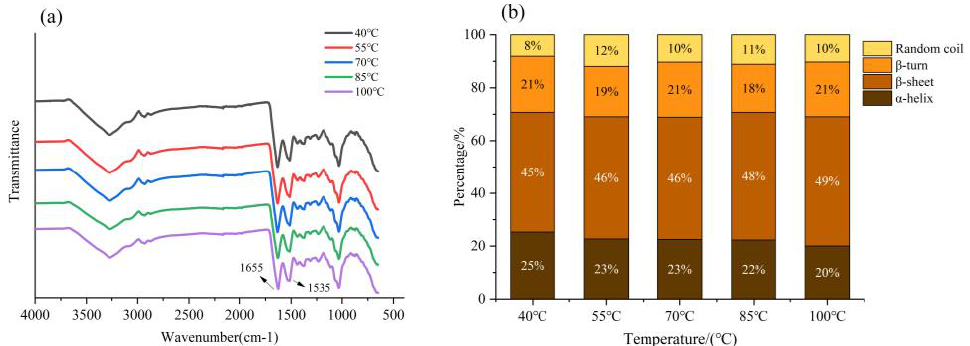
Figure 6. ( a ) FTIR spectrum of EBN insoluble fraction; ( b ) the secondary structure contents. The spectra in the wavenumber range of 1700 – 1600 cm −1 were analyzed by